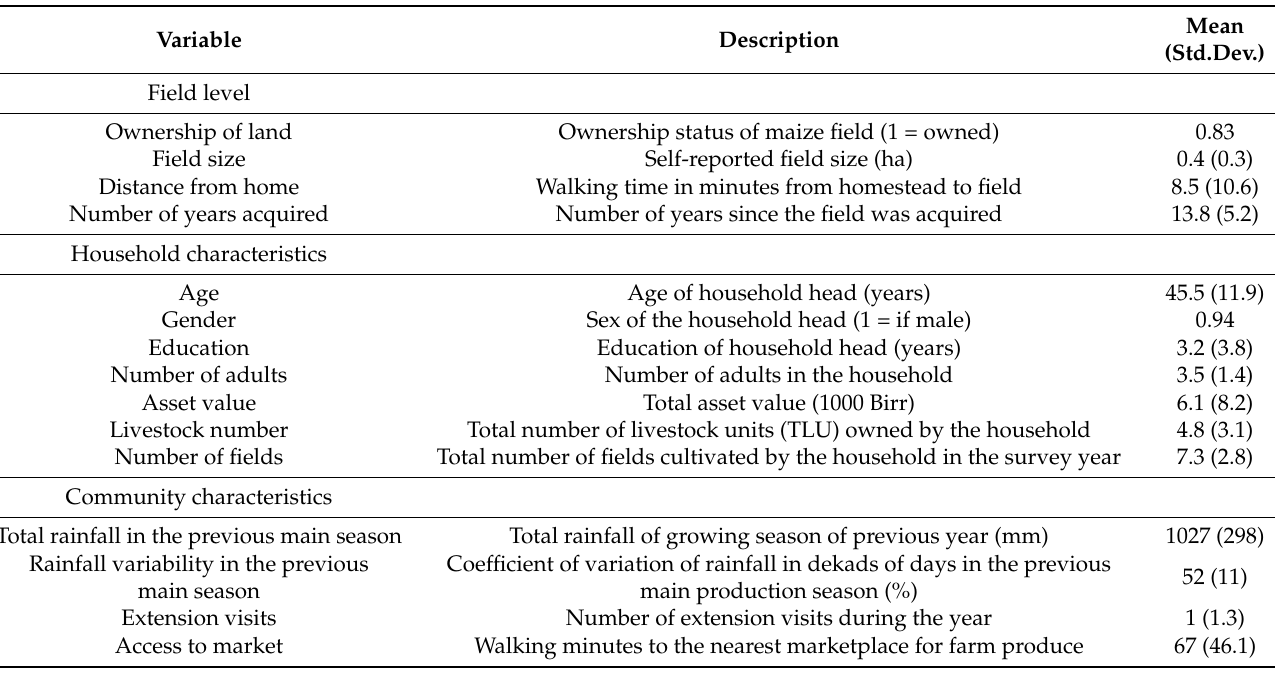
Table 3. Description and summary statistics of the explanatory